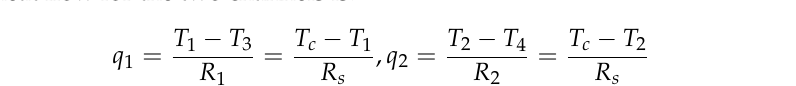
Figure 2. The diagram of DHF, with the copper material situated around the rubber